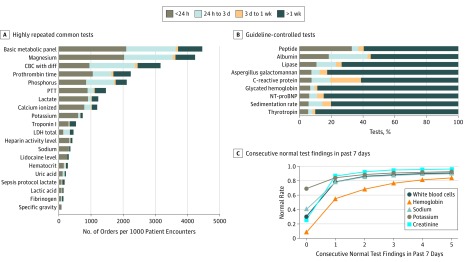
Prevalence of Repetitive Tests and Their Diminishing Information GainA, Most commonly repeated laboratory test orders from July 1, 2014, to June 30, 2017, at Stanford University Hospital. The total length of each bar represents the total volume of laboratory orders per 1000 patient encounters, with shaded regions reflecting how many of these were repeated orders within a given time. For example, 47% of basic metabolic panels were subsequent tests performed again within 24 hours of the past order. Results were sorted by this number of repeated tests within 24 hours. B, Distribution of repeated orders for laboratory tests specifically identified as rarely ever having clinical justification for repeated daily testing.38 For example, 18.3% of albumin and 6.7% of glycated hemoglobin inpatient tests were performed again within 24 hours, even when it was not biologically plausible for the results to meaningfully change that rapidly. C, Prevalence of normal results for common laboratory components progressively increased toward 100% as more subsequent normal results were observed in the prior week. CBC with diff indicates complete blood cell count with differential; LDH, lactate dehydrogenase; NT-proBNP, N-terminal pro–brain-type natriuretic peptide; and PTT, partial thromboplastin time.